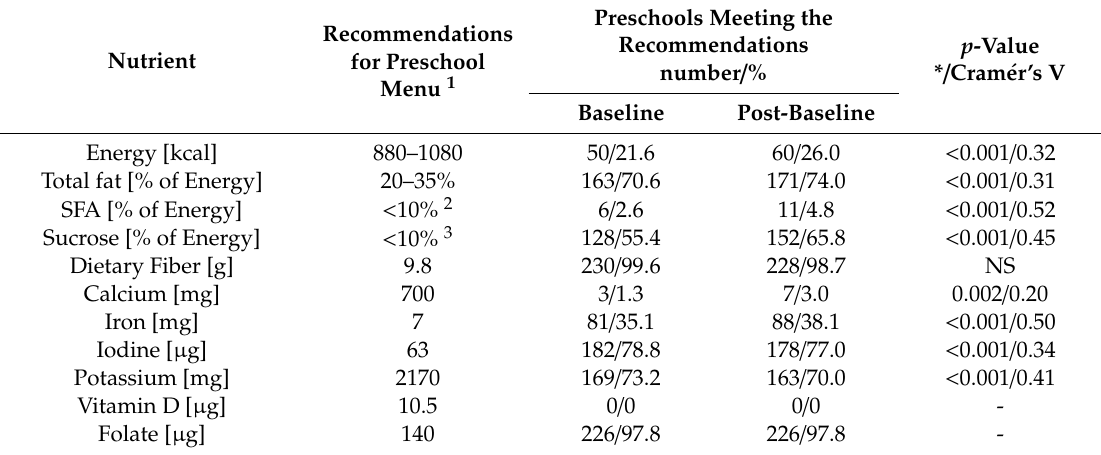
Table 5. The adequate supply of nutrients important for the overall diet quality in 231 preschools’ 10-day menus before (baseline) and after (post-baseline) the education program.